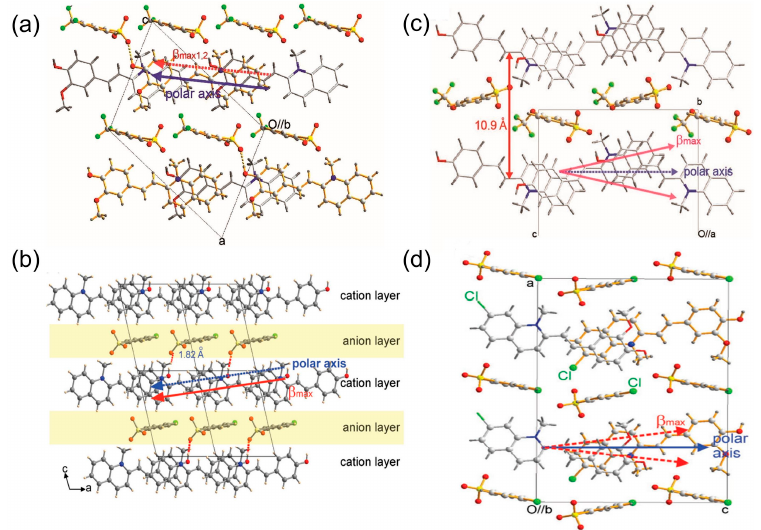
Figure 6. ( a ) Molecular packing diagram of HMQ-4TFS [29] and ( b ) OHQ-CBS crystals projected along the crystallographic b -axis [44]; ( c ) molecular packing diagram of OHQ-TFO crystal projected along the crystallographic a -axis [45]; and ( d ) molecular packing diagram of HM7ClQ-CBS crystal along the a -axis [42]. 2.2.4. Effects of Halogen-Free Anions on the Spatial Arrangement The T anion group is one of the classical anions, not only in pyridium-based DAST, but also in quinolinium-based compounds. With the help of T anions, the earliest classical HMQ and OHQ chromophores can be induced in asymmetrically crystal space groups, with the SHG intensity separately reaching 0.63 and ~1 times that of DAST under 1.9 µm and 1245 nm fundamental light [38,40]. Due to this, T anions are also introduced in com-